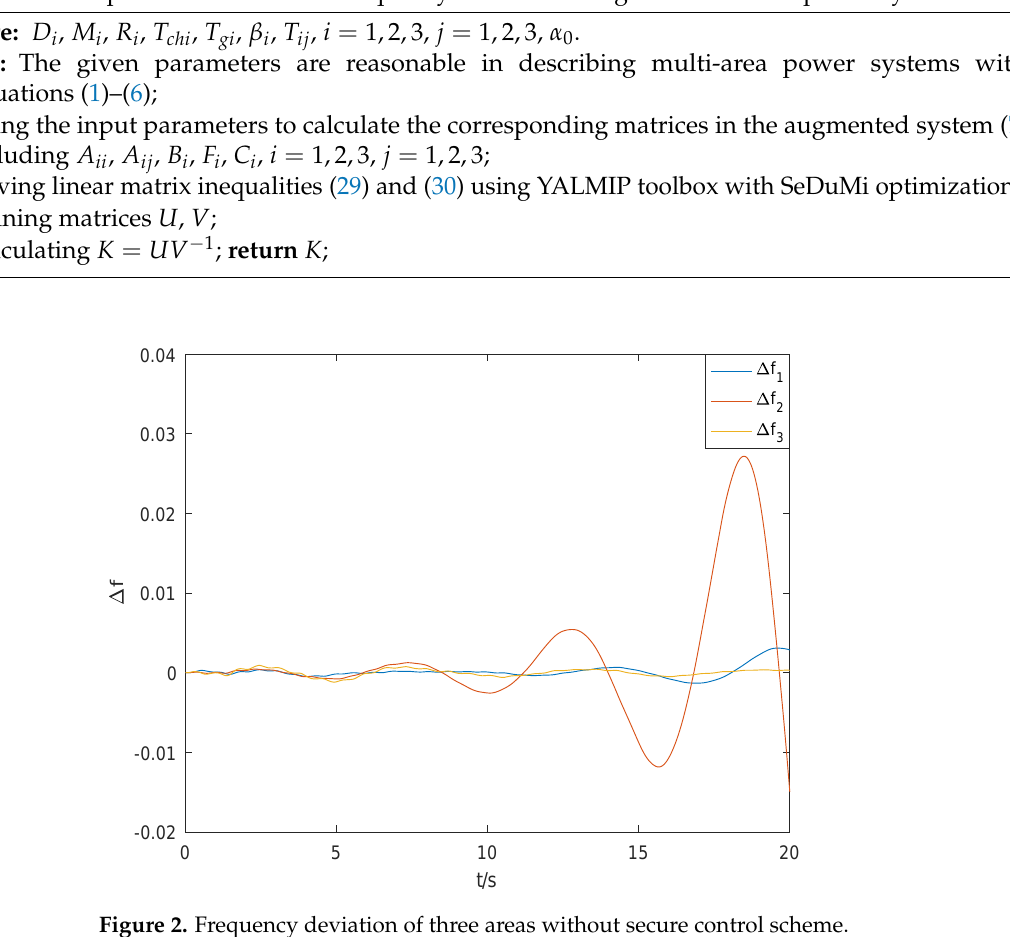
Figure 2. Frequency deviation of three areas without secure control scheme.